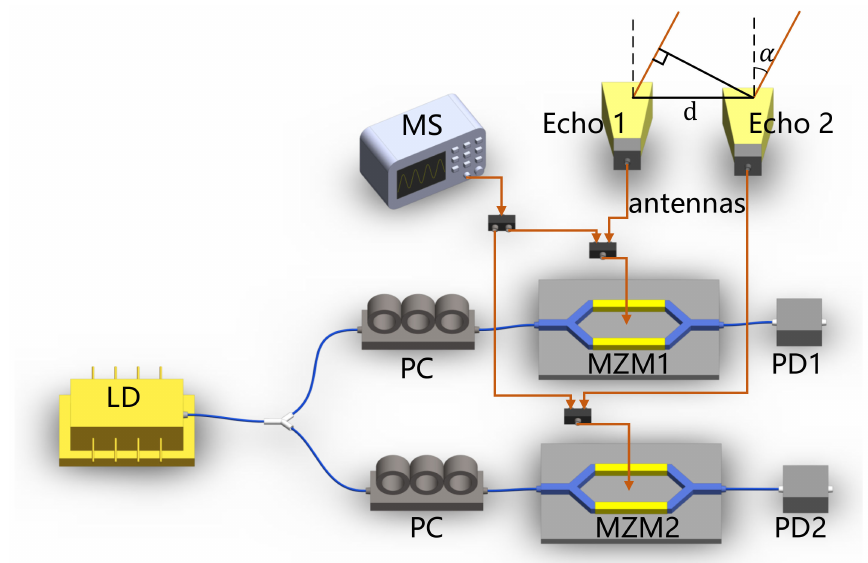
Figure 1. Schematic diagram of the proposed system for DFS and AOA measurement. LD: laser diode; PC: polarization controller; MZM: Mach–Zehnder modulator; PD: photodetector; MS: mi- crowave source.